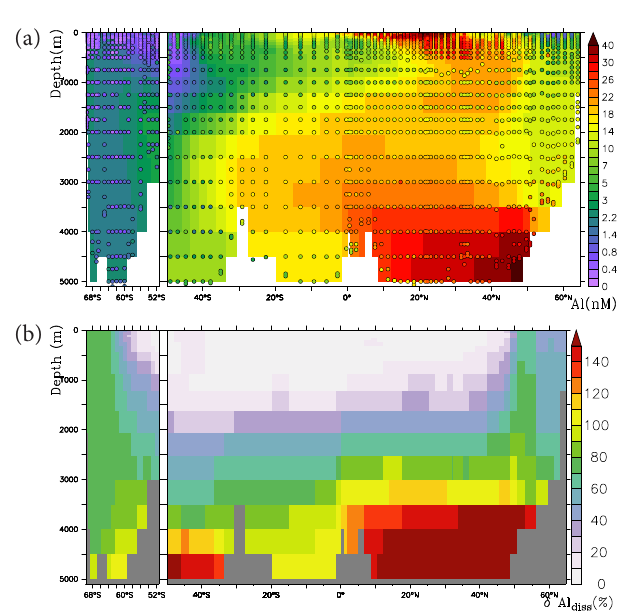
Figure 7. Results from the [ Si diss ] -dependent sediment resuspen- sion simulation following Mackin and Aller (1986) of year 500 after forking; sections along the Zero Meridian and West Atlantic GEO- TRACES transects. (a) Modelled [ Al diss ] (nM) with observations plotted as coloured dots. (b) Relative difference of [ Al diss ] between SedMackin and RefDyn2